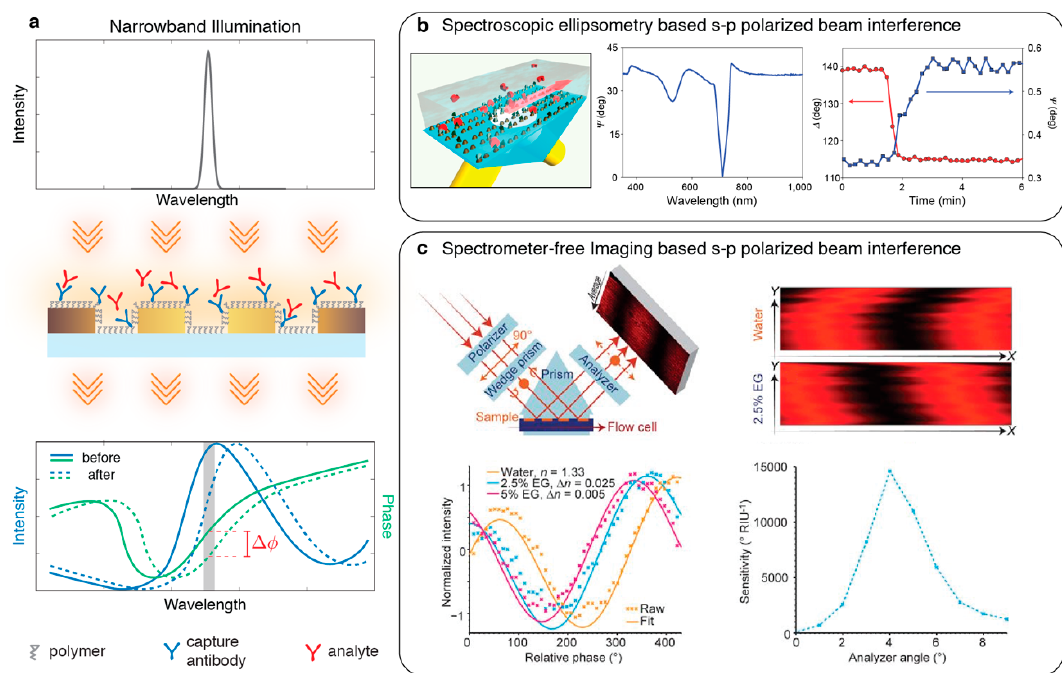
Figure 8. ( a ) Phase interrogation of nanophotonic sensors. In this representative schematic a collinear light-path is shown. A narrowband light tuned to the localized surface plasmon peak, where the phase shift gradient is high, is used for excitation. The red-shift in the spectral position of the resonance leads to a shift in the phase function, which can be interrogated using an interferometry technique to extract quantitative analyte binding information; ( b ) (left) singular phase response of plasmonic metasurface was probed by spectroscopic ellipsometry in a total internal reflection configuration. (middle) Ellipsometric spectral response of nanoplasmonic sensor. (right) Time-traced phase change signal measured during a bioassay. Adapted by permission from Nature Publishing Group [91], Copyright 2013; ( c ) (top-left) Schematic showing reflection optical configuration where the nanoparticle layer was interrogated using spatially varying polarization states of a collimated laser diode beam. Interaction between the p- and s-polarized reflection components create interference fringes on a charge-coupled device (CCD) imager (top-right). (bottom-left) The fringes shift as the ambient refractive index increases. (bottom-right) Sensitivity dependence on the analyzer angle. Adapted with permission from [92] Copyright 2014 Nature Publishing Group.